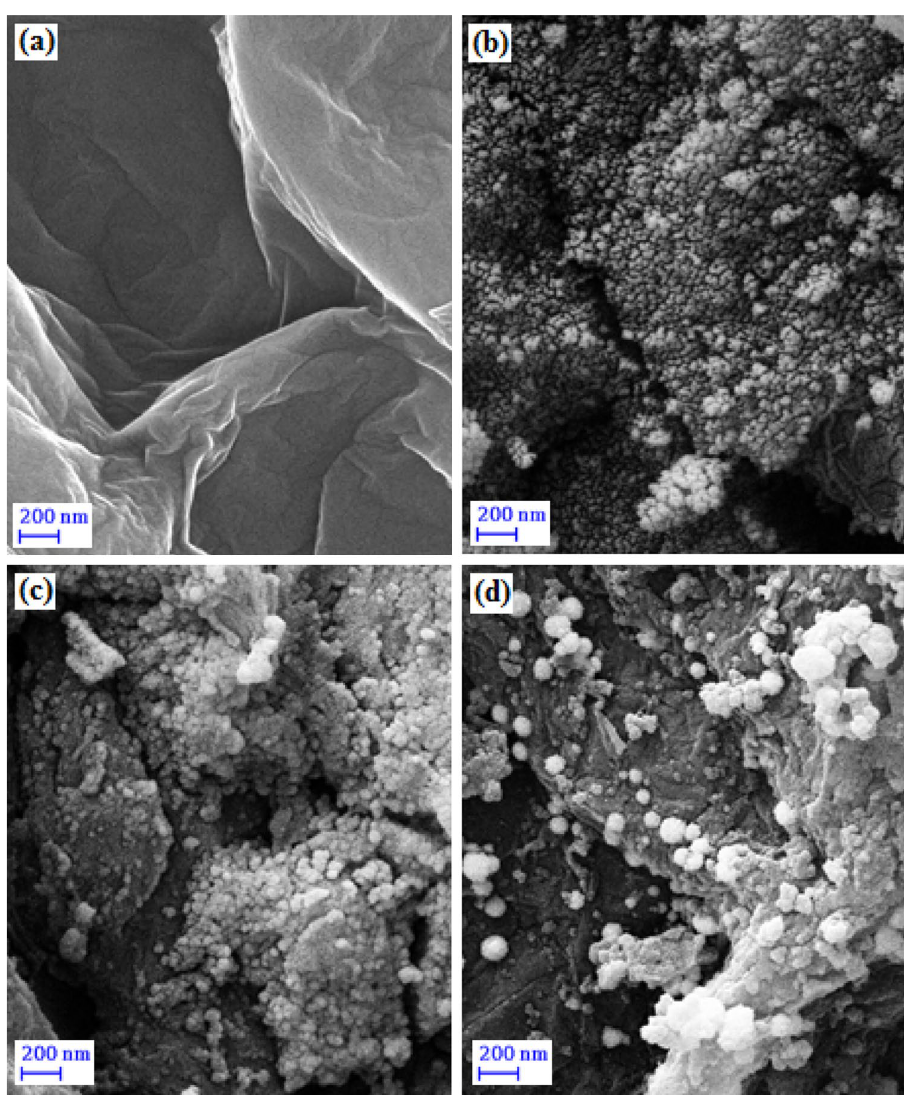
Figure 2. SEM images of ( a ) GO, ( b ) GO/Fe 3 O 4 , ( c ) GO/Fe 3 O 4 @PDA,and ( d ) GO/Fe 3 O 4 @PDA/Au